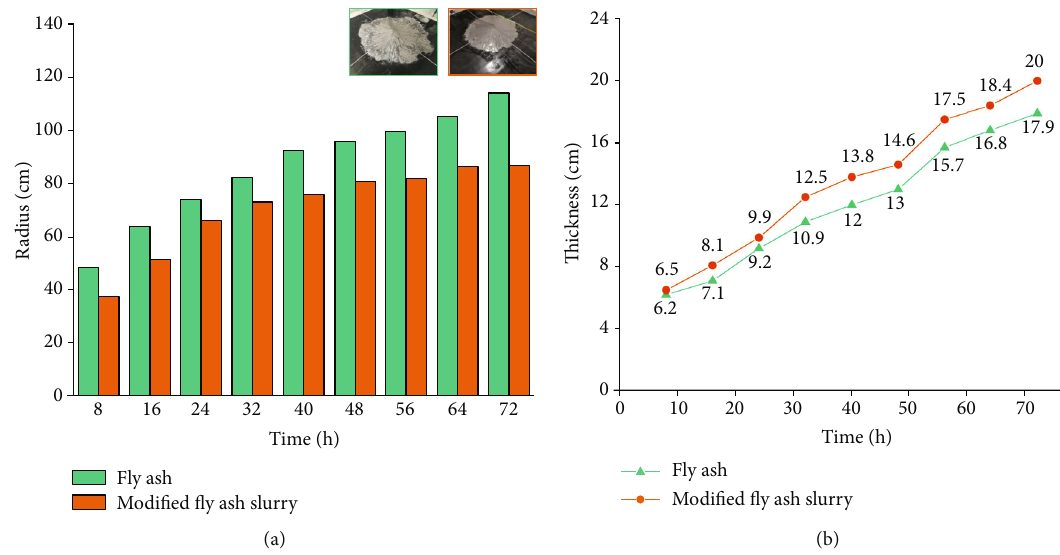
Figure 6: Comparison of slurry fl ow. (a) Slurry di ff usion radius and (b) thickness of deposited